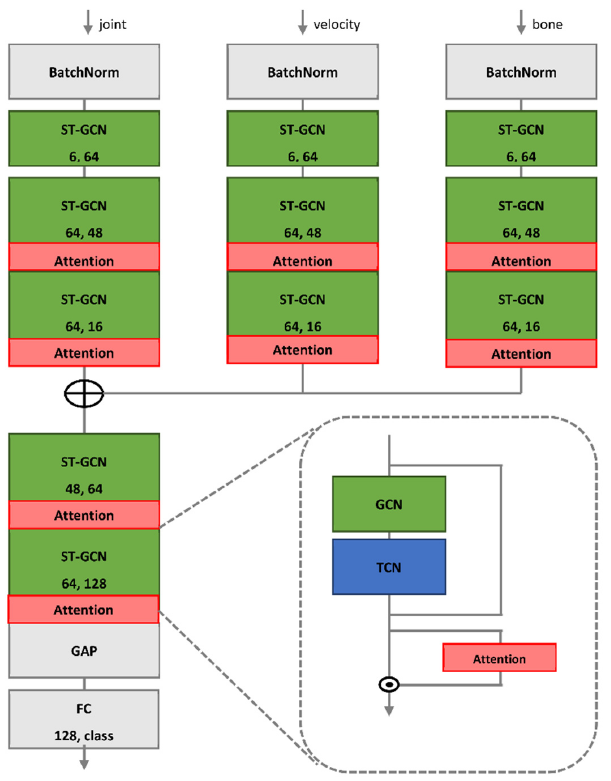
Figure 4. Overview of proposed model. Two numbers in each block denote input and output channels, and ⊕ represents concatenation.